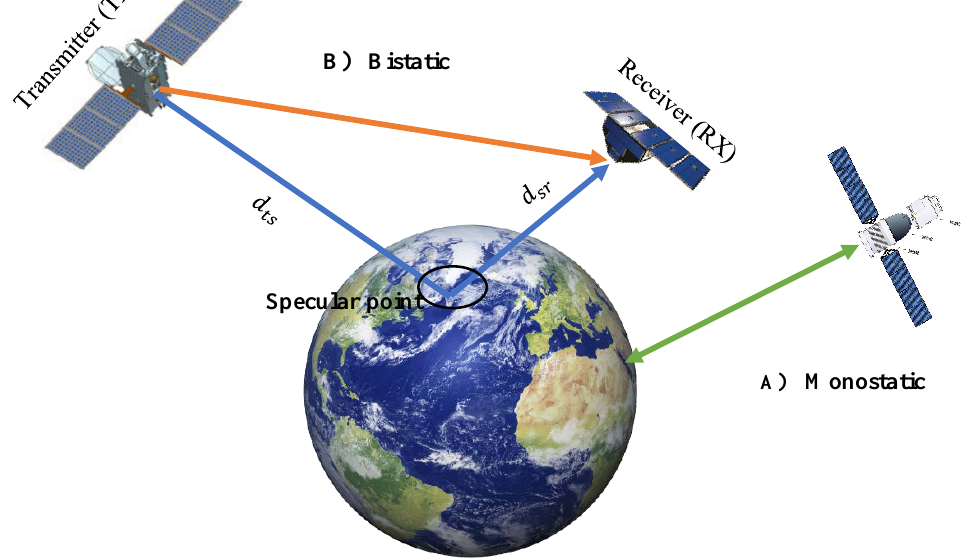
Figure 6. Simple schematic view of mono ( A ) and bistatic ( B ) radars constellation for satellite remote